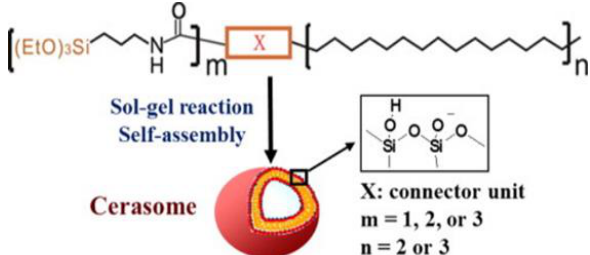
Figure 19. General concept of cerasome: a vesicle that is constructed of cerasome forming lipids that undergo hydrolysis upon forming a bilayer and covalently link with each other via Si-O-Si bonds. Reprinted with permission from [267]. Copyright 2014 Elsevier.